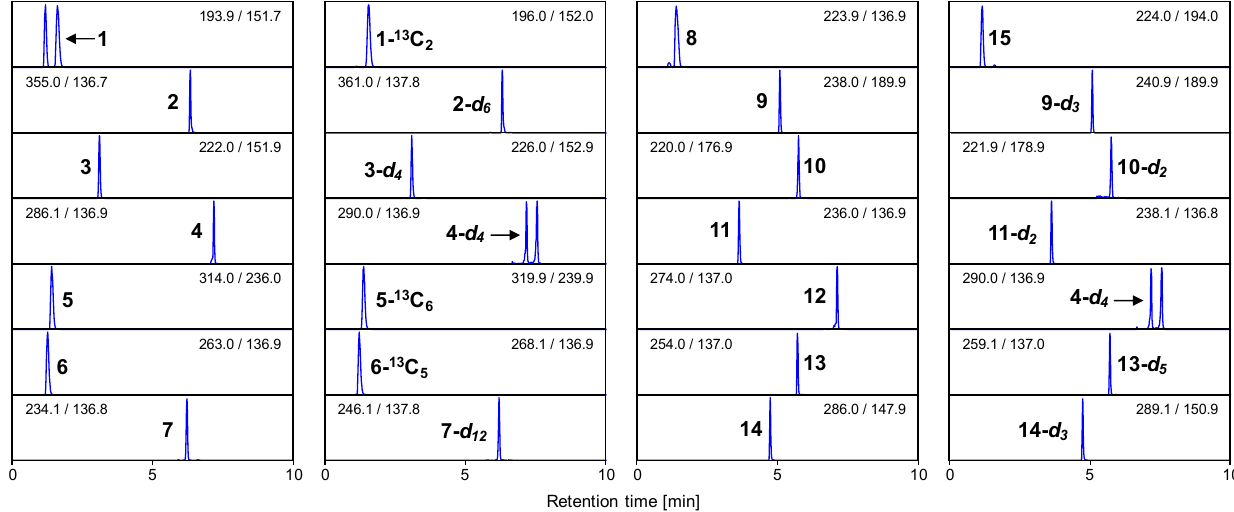
Figure 4. UHPLC–MS/MS mass transitions of the 3-NPH derivatized analytes and their correspond- ing internal standards: acetic acid ( 1 ), 2,3-butanedione ( 2 ), butyric acid ( 3 ), ( E , E )-2,4-decadienal ( 4 ), D -fructose ( 5 ), L -glutamic acid ( 6 ), hexanal ( 7 ), lactic acid ( 8 ), methional ( 9 ), 3-methylbutanal ( 10 ), 3-methylbutyric acid ( 11 ), ( E )-2-nonenal ( 12 ), phenylacetaldehyde ( 13 ), vanillin ( 14 ), acetic acid- 13 C 2 ( 1 - 13 C 2 ), 2,3-butanedione- d 6 ( 2 - d 6 ), butyric acid- d 4 ( 3 - d 4 ), ( E , E )-2,4-decadienal- d 4 ( 4 - d 4 ), D -fructose- 13 C 13 C 13 C 13 C 6 ( 5- 6 ), L -glutamic acid- 5 ( 6 - 5 ), hexanal- d 12 ( 7 - d 12 ), 3-hydroxypropionic acid ( 15 ), methional- d 3 ( 9 - d 3 ), 3-methylbutanal- d 2 ( 10 - d 2 ), 3-methylbutyric acid- d 2 ( 11 - d 2 ), phenylacetaldehyde- d 5 ( 13 - d 5 ), and vanillin- d 3 ( 14 - d 3 ). The signal intensity of each mass transition was normalized.